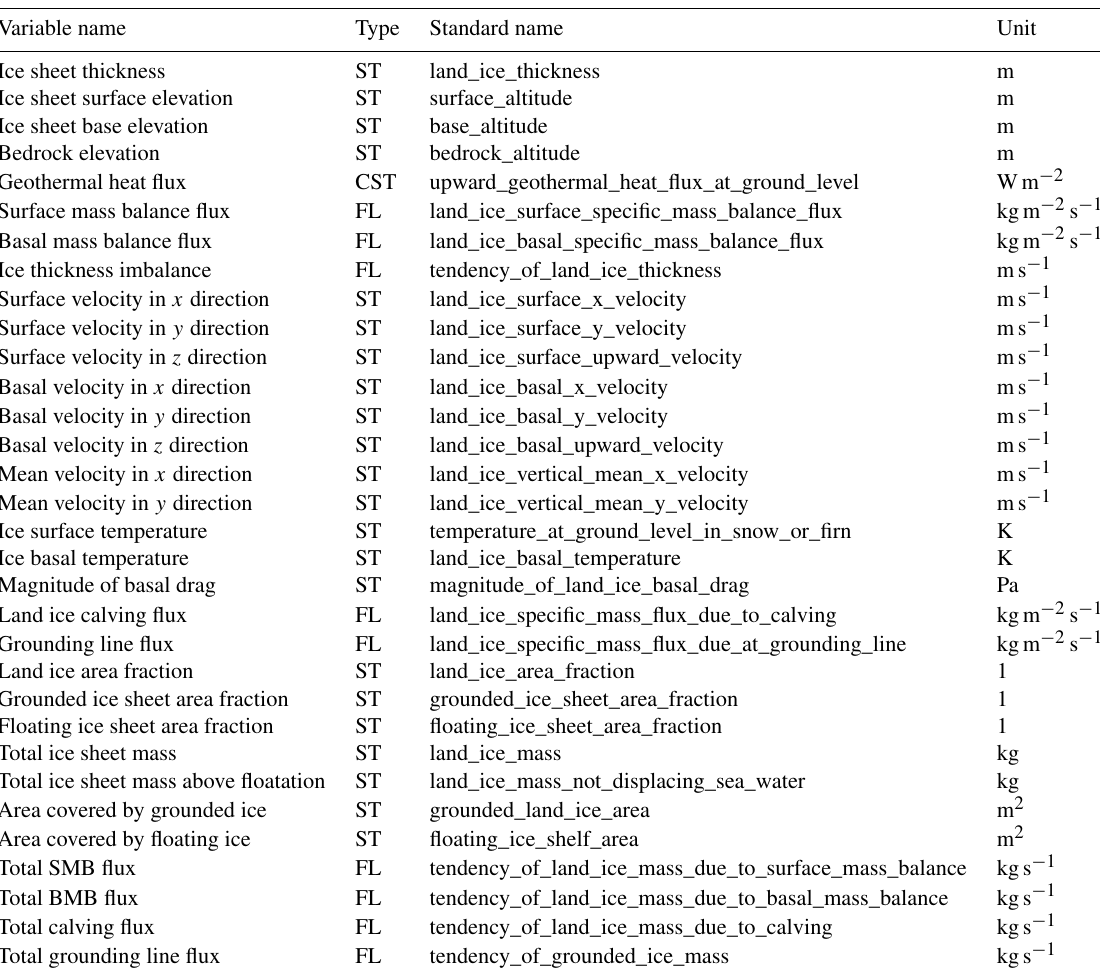
Table A1. Data requests for initMIP-Antarctica. ST: state variable. FX: flux variable. CST: